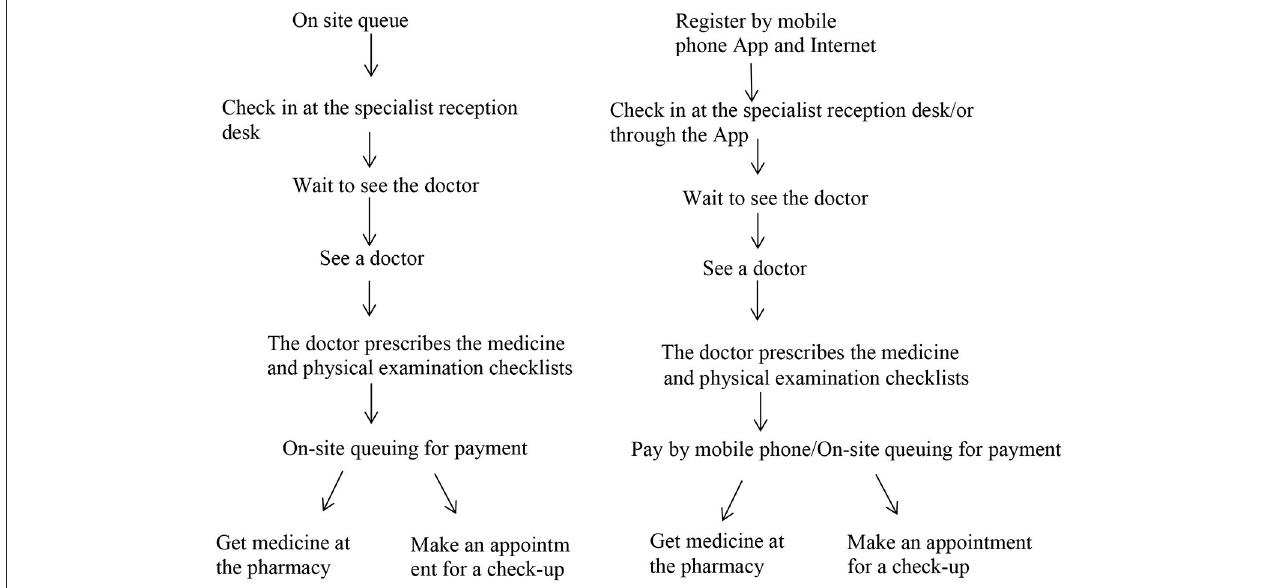
FIGURE 1 | Comparison between the past and the current hospital procedures for outpatient services.